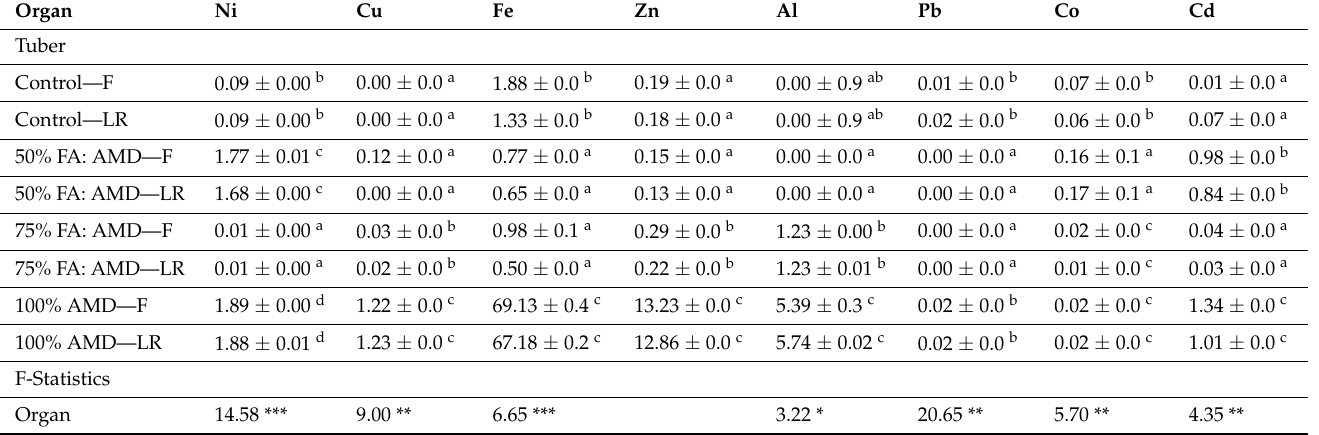
Table 1. Heavy metal distribution from acid mine water drainage (AMD) water mixed with fly ash (FA) on the plant tissue (tuber) of two cultivars of potato. Values (Mean ± S.E.) followed by similar letters in a column are not significantly different at p ≤ 0.05, ** p ≤ 0.01, *** p ≤ 0.001. NS = not